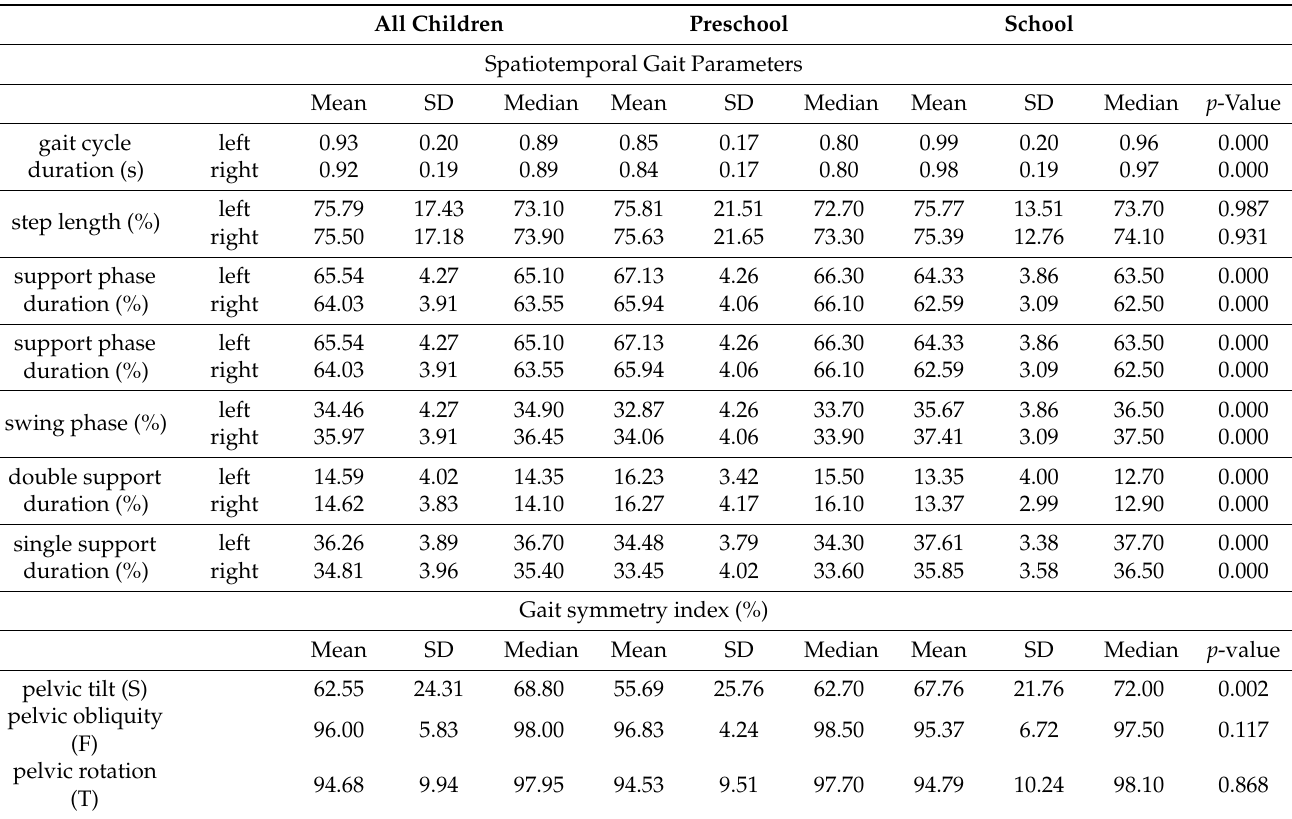
Table 3. Spatiotemporal gait parameters in examined group. p -value is described for difference between P and S in means. All Children